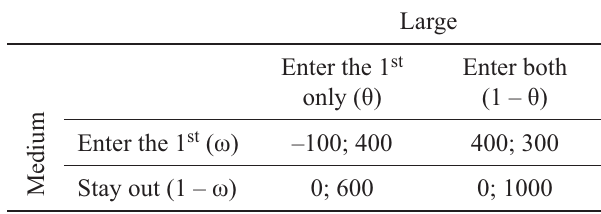
Table 1. The entrance game payoff matrix Incumbent